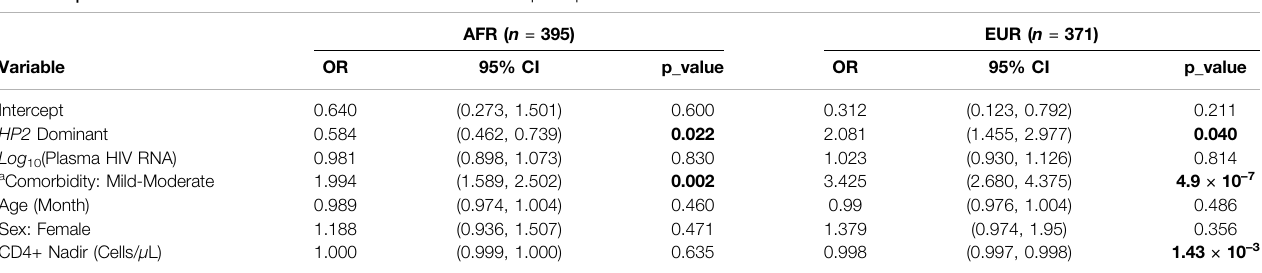
TABLE 2 | Baseline HP2 dominant effect on NCI in the AFR and EUR